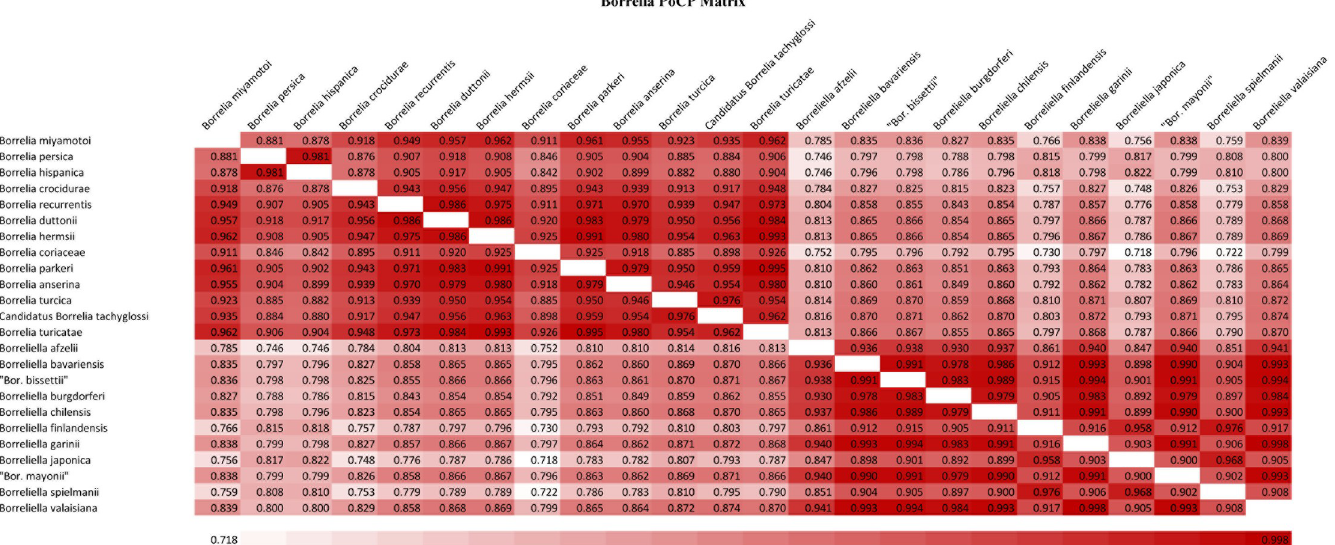
PLOS ONE | https://doi.org/10.1371/journal.pone.0221397 August 27,